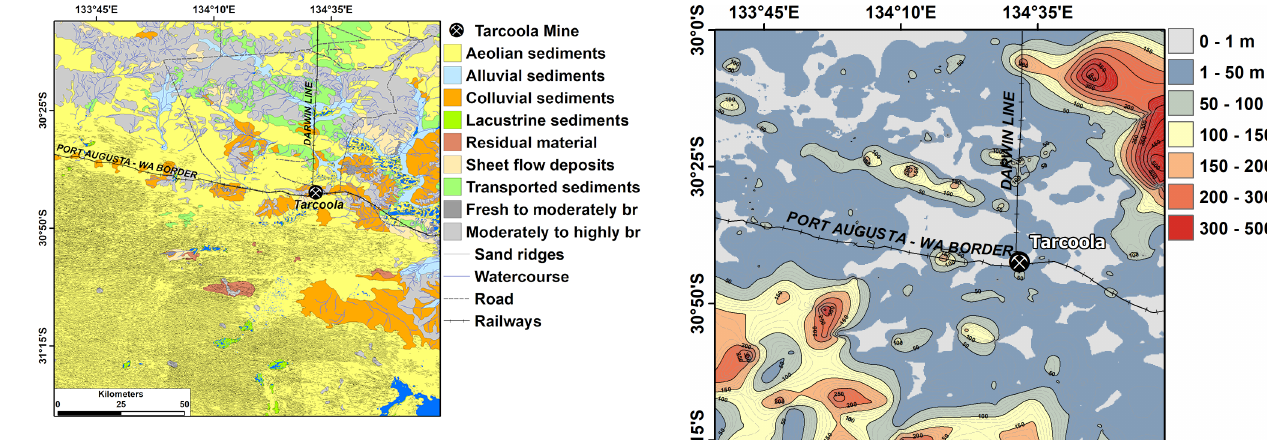
Figure 3. Surface feature map displaying regolith material (Krapf et al., 2012), roads, watercourses, and sand ridges. Especially linear structures such as roads and sand ridges are expected to strongly influence the automated lineament extraction process. br: bedrock.